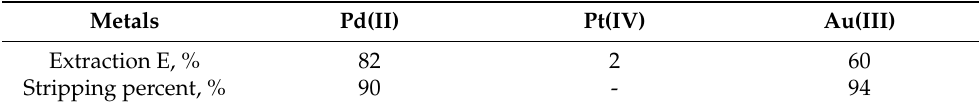
Table 6. The extraction efficiency (E,%) and the stripping percent of Au(III), Pd(II), and Pt(IV) from the e-waste model solution. Initial concentration of metals: 10 mg/dm 3 Pd, 8 mg/dm 3 Pt, and 10 mg/dm 3